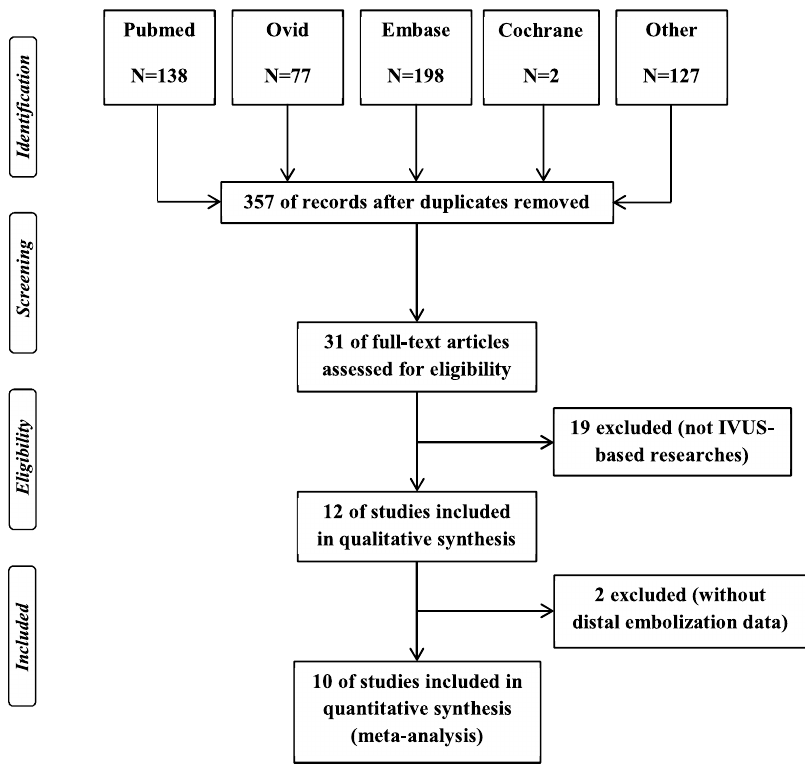
Figure 1. Process of study selection.